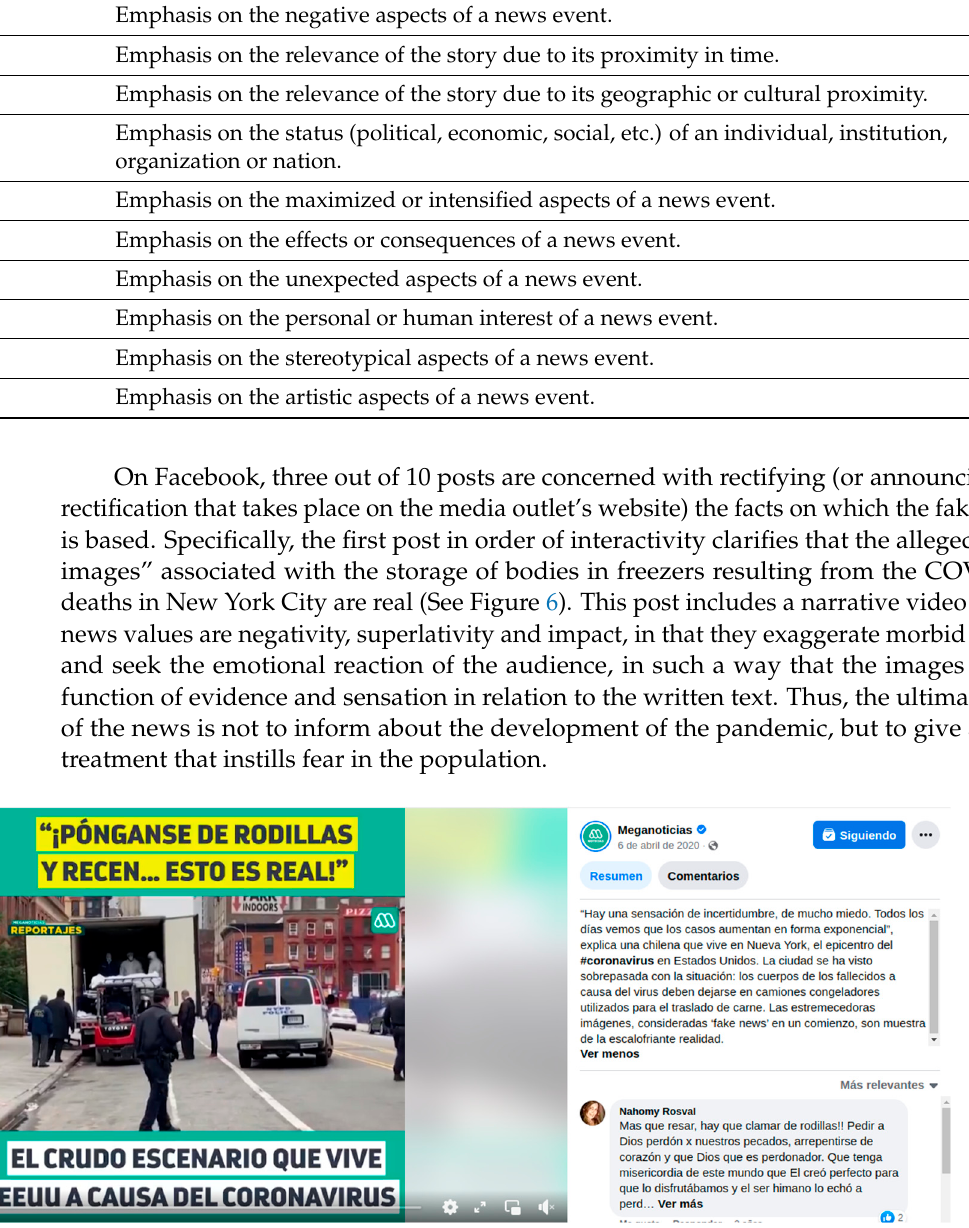
Table 2. News values construction (Caple, 2013).